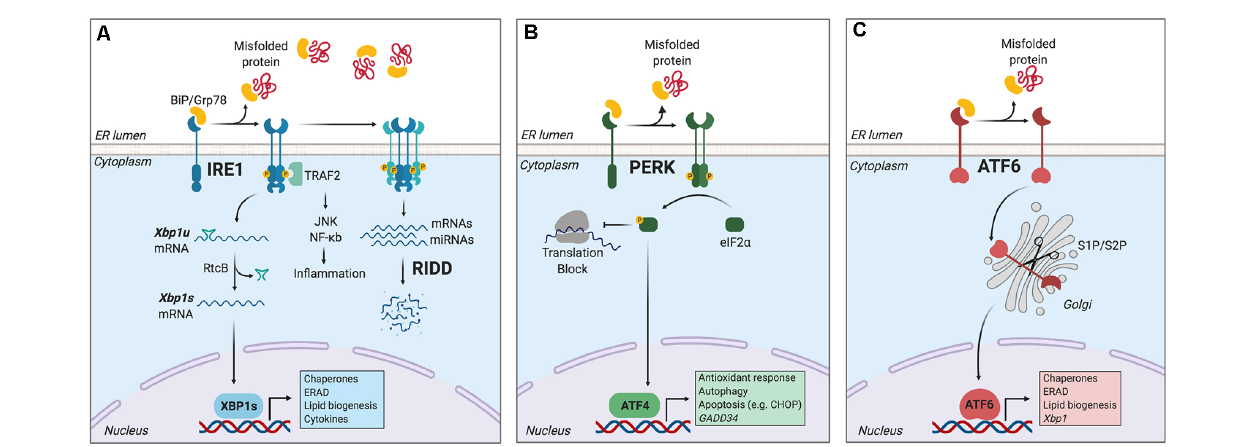
FIGURE 1 | The unfolded protein response (UPR). Endoplasmic reticulum (ER) stress induces an adaptive response known as the unfolded protein response (UPR), which is controlled by three main ER-resident sensors: IRE1, PERK, and activating transcription factor-6 (ATF6). (A) IRE1 is activated by oligomerization and trans-phosphorylation upon binding of unfolded proteins and release of the chaperone BiP. IRE1 autophosphorylation leads to the activation of its RNase domain and the processing of the mRNA encoding for X-box binding protein 1 (XBP1s), a transcriptional factor that upregulates genes involved in protein folding and quality control, in addition to regulating ER/Golgi biogenesis and ER-mediated degradation (ERAD), lipid biogenesis and cytokine production. Additionally, IRE1 RNase also degrades a subset of specific RNAs and microRNAs, a process termed Regulated IRE1-Dependent Decay (RIDD). (B) Upon activation, PERK phosphorylates the eukaryotic initiation factor-2 α (eIF2 α ), decreasing the synthesis of proteins and the overload of misfolded proteins at the ER. PERK phosphorylation also leads to the specific translation of ATF4, a transcription factor that promotes the expression of genes related to amino acid metabolism, antioxidant response, autophagy, and apoptosis. (C) ATF6 is activated upon release of BiP and is translocated to the Golgi, where it undergoes sequential cleavage and removal of its luminal domain. The remaining transactivation domain of ATF6 moves to the nucleus and coordinates the expression of genes encoding ER chaperones, ER-associated protein degradation (ERAD) components, and molecules involved in lipid biogenesis. Figure created with